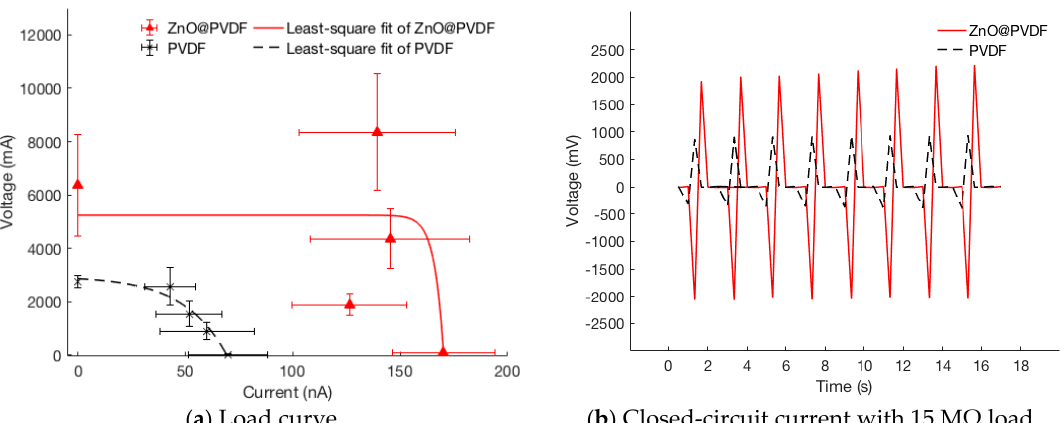
Figure 7. Nanogenerator characteristics for PVDF and ZnO@PVDF 15 cm 2 fiber mat: ( a ) load curves with resistive loads of 0.47, 15, 30, and 60 M Ω ; ( b ) transient closed-circuit current measurements with the 15 M Ω resistive load. Table 2. Measured closed-circuit current and voltage averages with conductive knitted fabric electrodes.